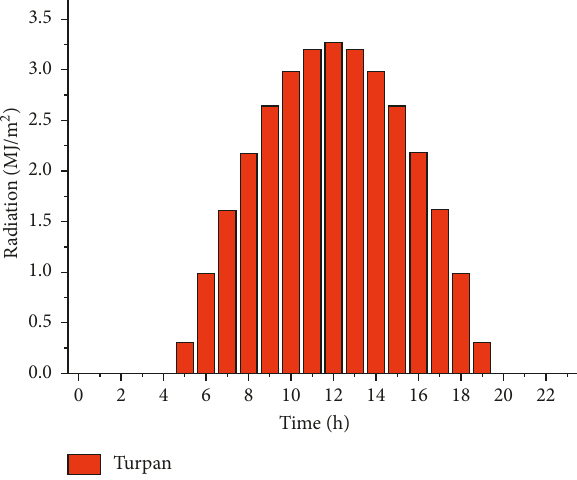
Figure 10: Radiation conditions on representative